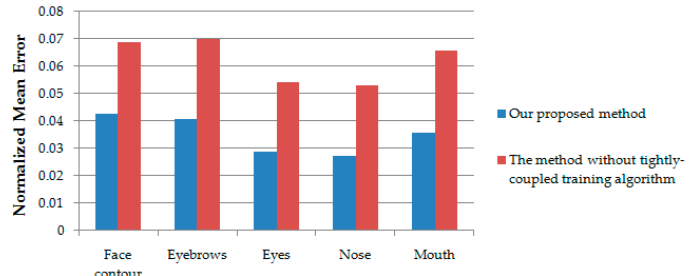
Figure 12. Normalized mean errors of our proposed method versus the method without the tightly-coupled training algorithm.